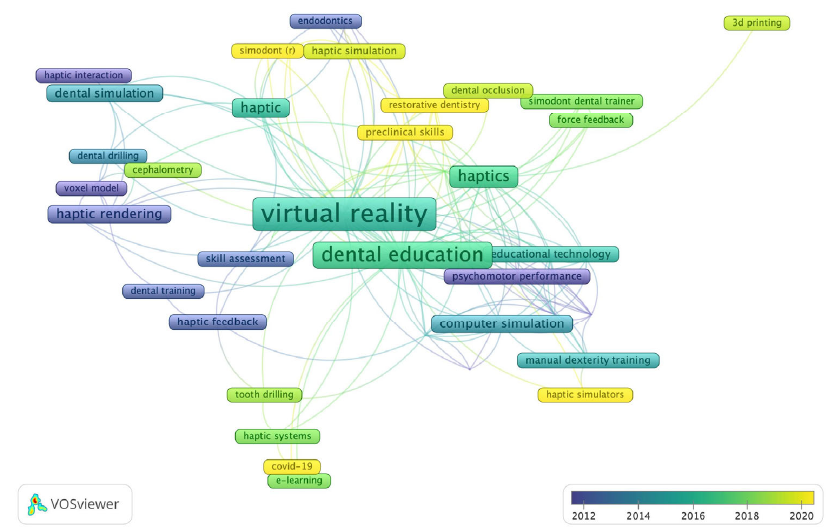
Figure 7. Yearly distribution of overlay author keyword visualization after normalization. It shows